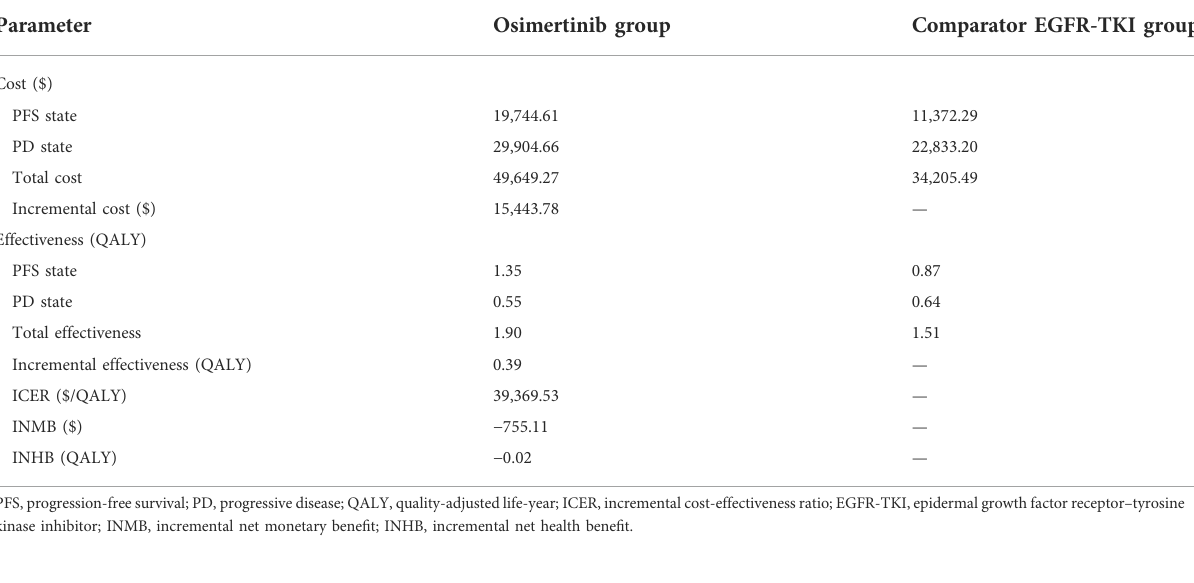
TABLE 3 Cost and outcome results in the base-case analysis.